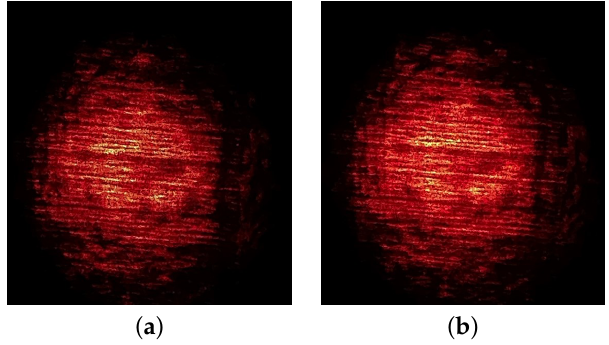
Figure 2. Sample digital images collected during the experiment. ( a ) Original (un-stretched) Image, ( b ) Stretched